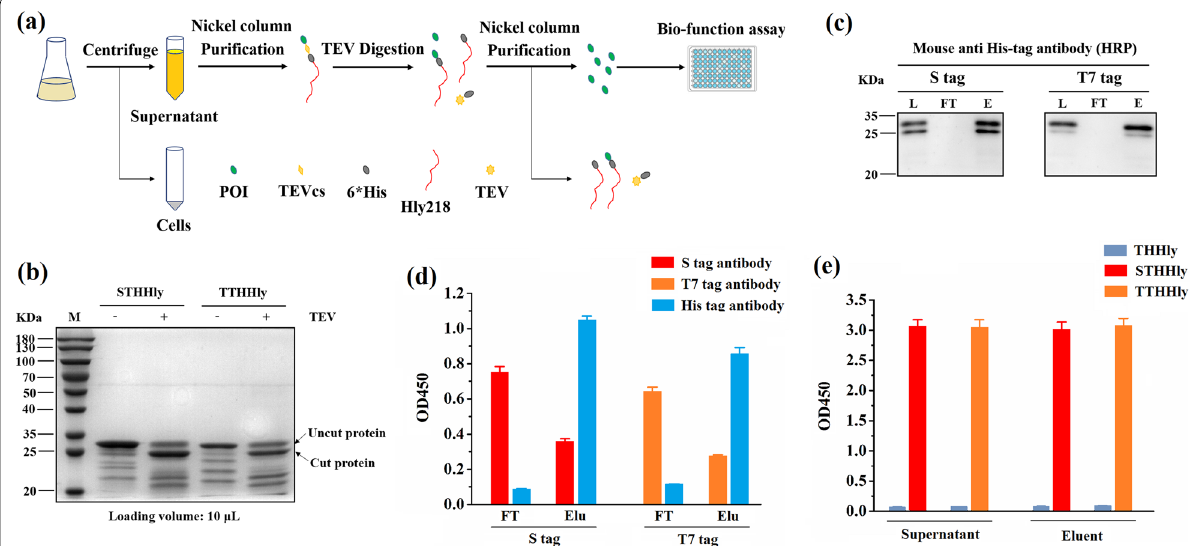
Fig. 5 Secondary purification of the tags and verification of the immunogenicity. a Technical map of the purification procedure. b Digestion of STHHly and TTHHly with TEV enzyme. c Purification of S tag and T7 tag. L loading sample, FT flow through, E eluent. The samples were detected by a mouse anti-His tag antibody. d , e Verification of the immunogenicity of the tags in FT ( d ), eluent and supernatant ( e ). Elu